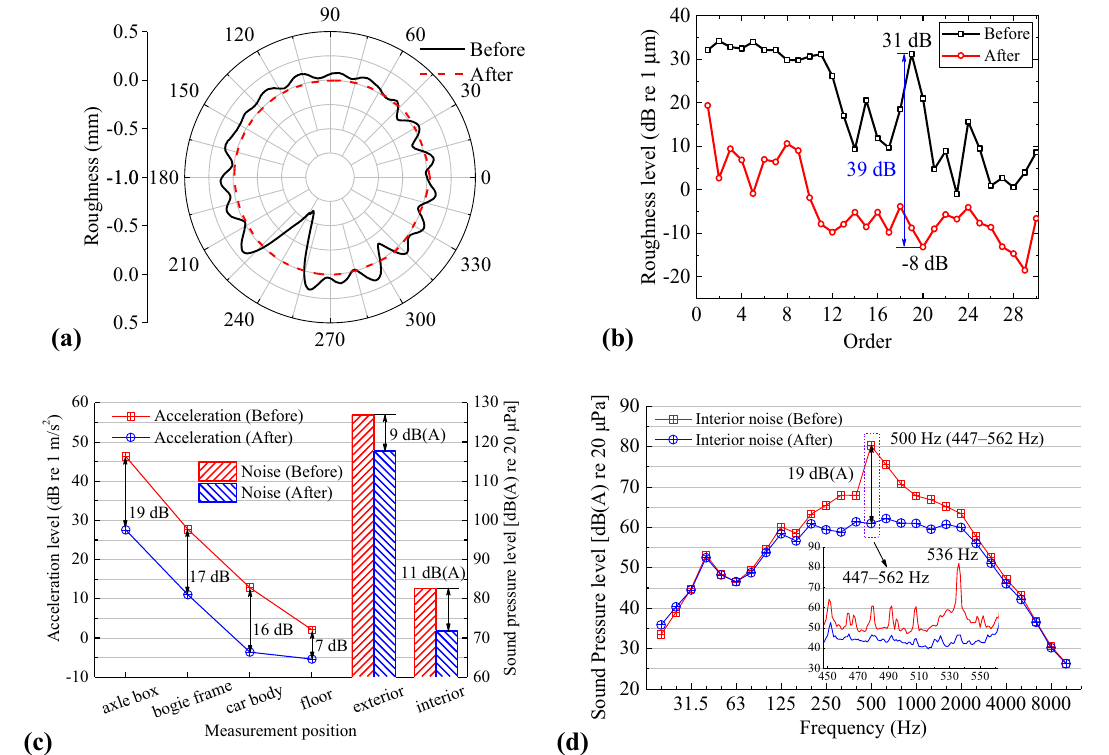
Fig. 12 Noise and vibration of high-speed train caused by wheel polygonisation [51]. Wheel roughness is described in a polar coordinates and b harmonic orders. Noise and vibration before and after wheel re-profiling: c overall levels and d 1/3-octave band and narrowband